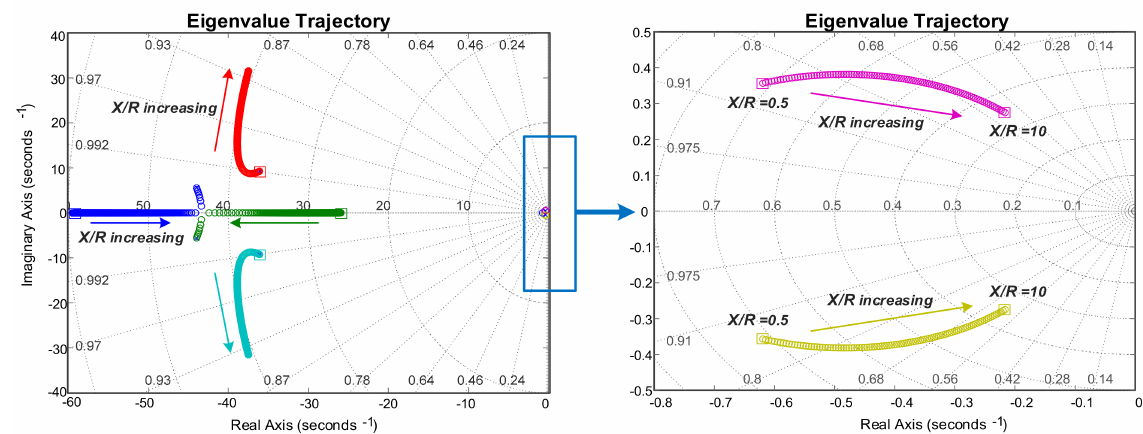
Figure 19. Eigenvalue trajectory for line